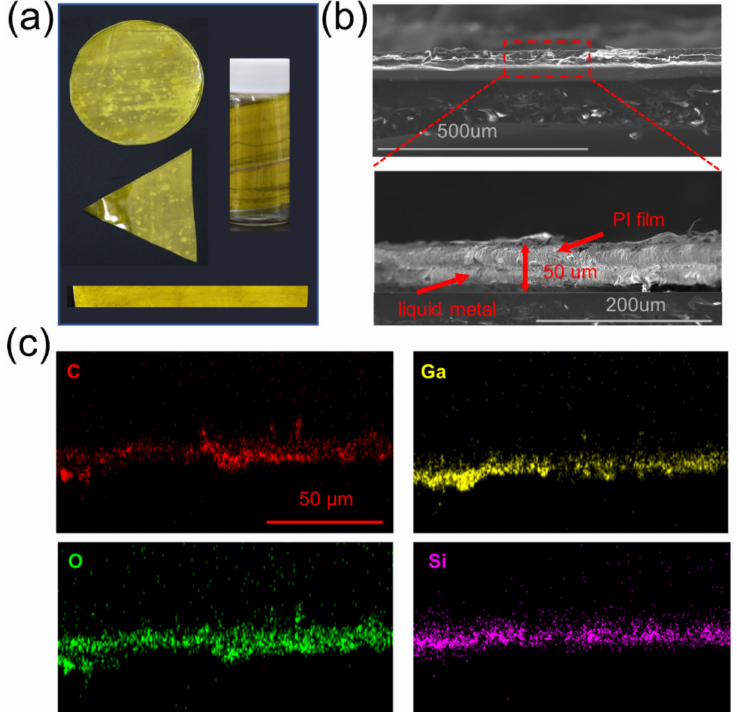
Figure 5. ( a ) Optical images with different shapes of the composite film. ( b ) SEM morphology of the preparing electrothermal film. ( c ) The elemental distribution of the preparing electrothermal